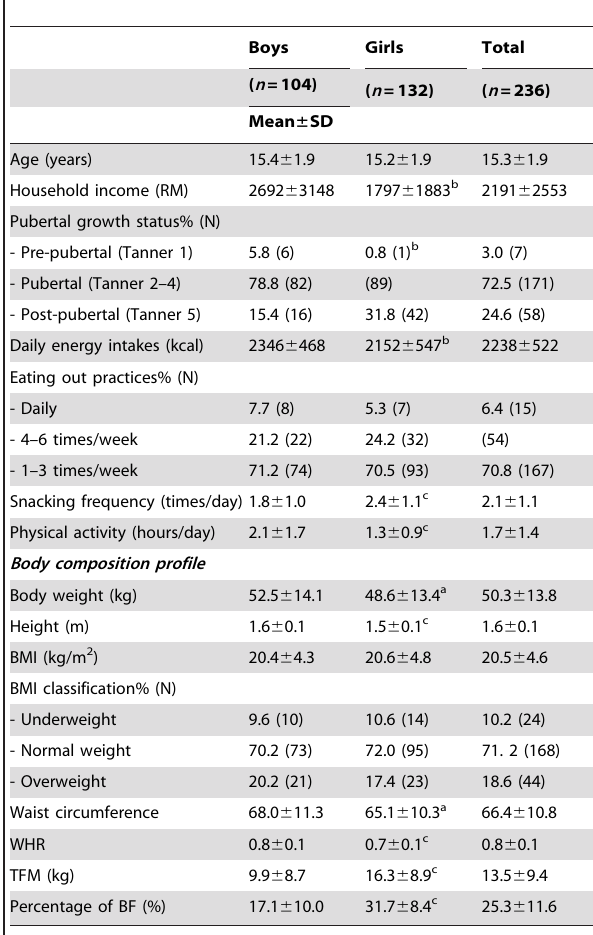
Table 1. General characteristics and body composition profiles of school-aged adolescent boys and